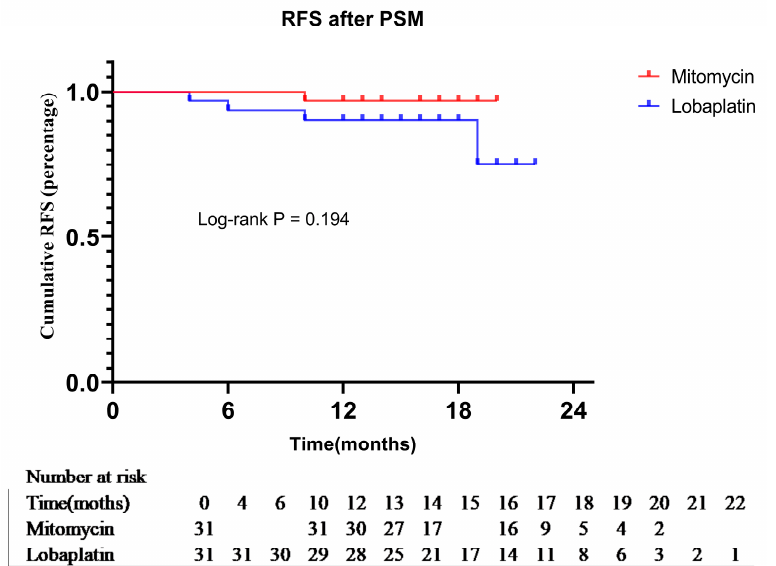
Figure 4. Kaplan-Meier method was used to recurrence-free survival between the Mitomycin group and Lobaplatin group after